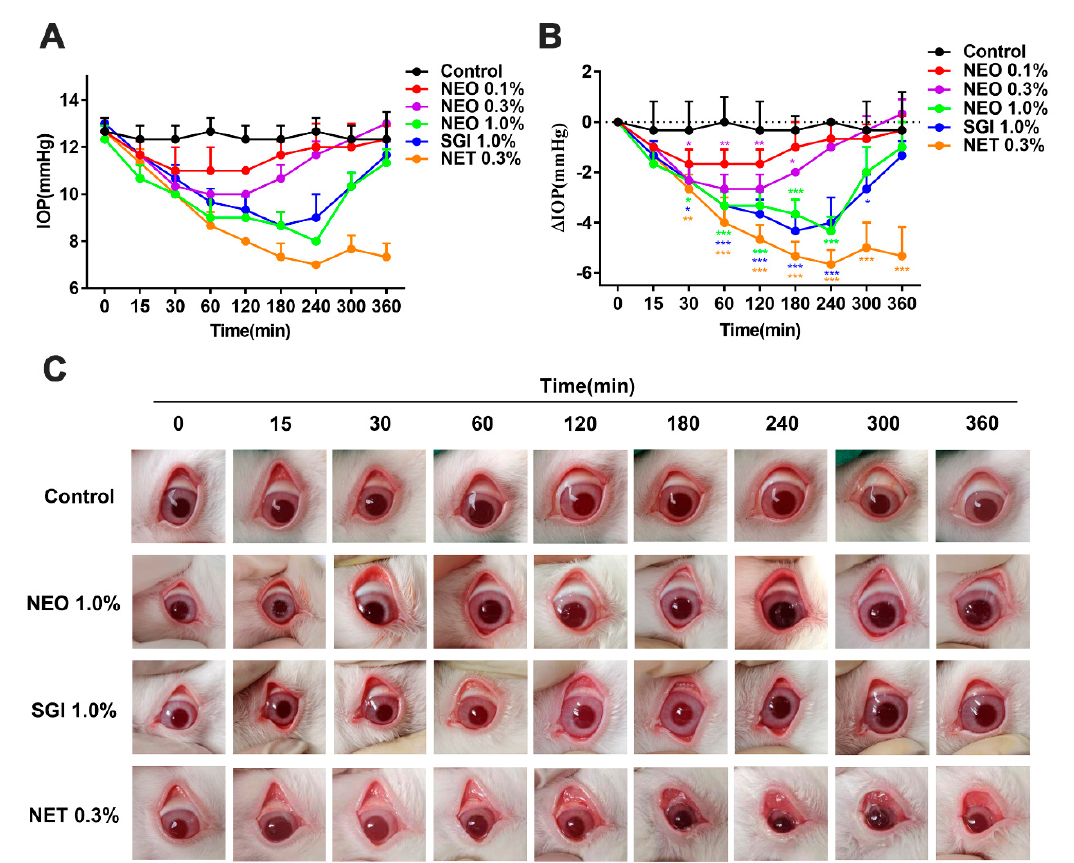
Figure 7. NEO, SGI-1776 and NET decreased IOP. ( A ) IOP levels prior to treatment and at 15, 30, 60, 120, 180, 240 and 300 min after treatment. ( B ) Changes in IOP ( ∆ IOP) at 15, 30, 60, 120, 180, 240 and 300 min after treatment; ( C ) A representative image of conjunctival hyperemia at 0, 15, 30, 60, 120, 180, 240 and 300 min after dose administration. Each value is the mean ± SD for n = 3. * p < 0.05, ** p < 0.01, *** p < 0.001 versus control group.